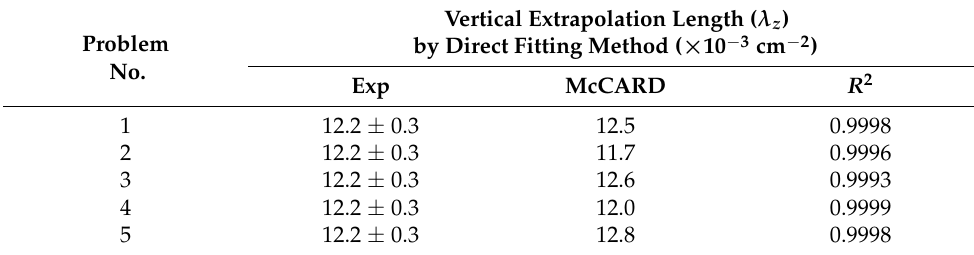
Figure 4. Normalized vertical flux and its fitted function for the direct fitting method. Table 3. Vertical extrapolation lengths of TCA experiment benchmark problems.